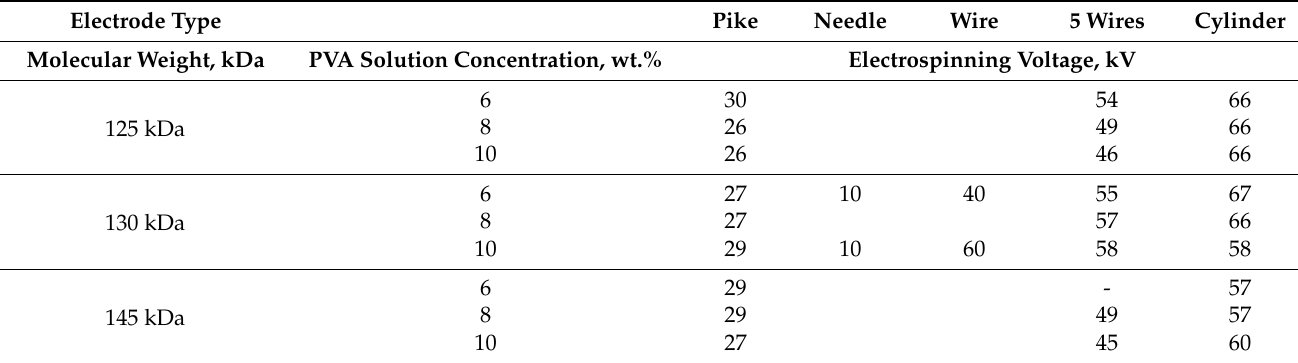
Table 2. The electrospinning parameters, electrode type and solution concentration